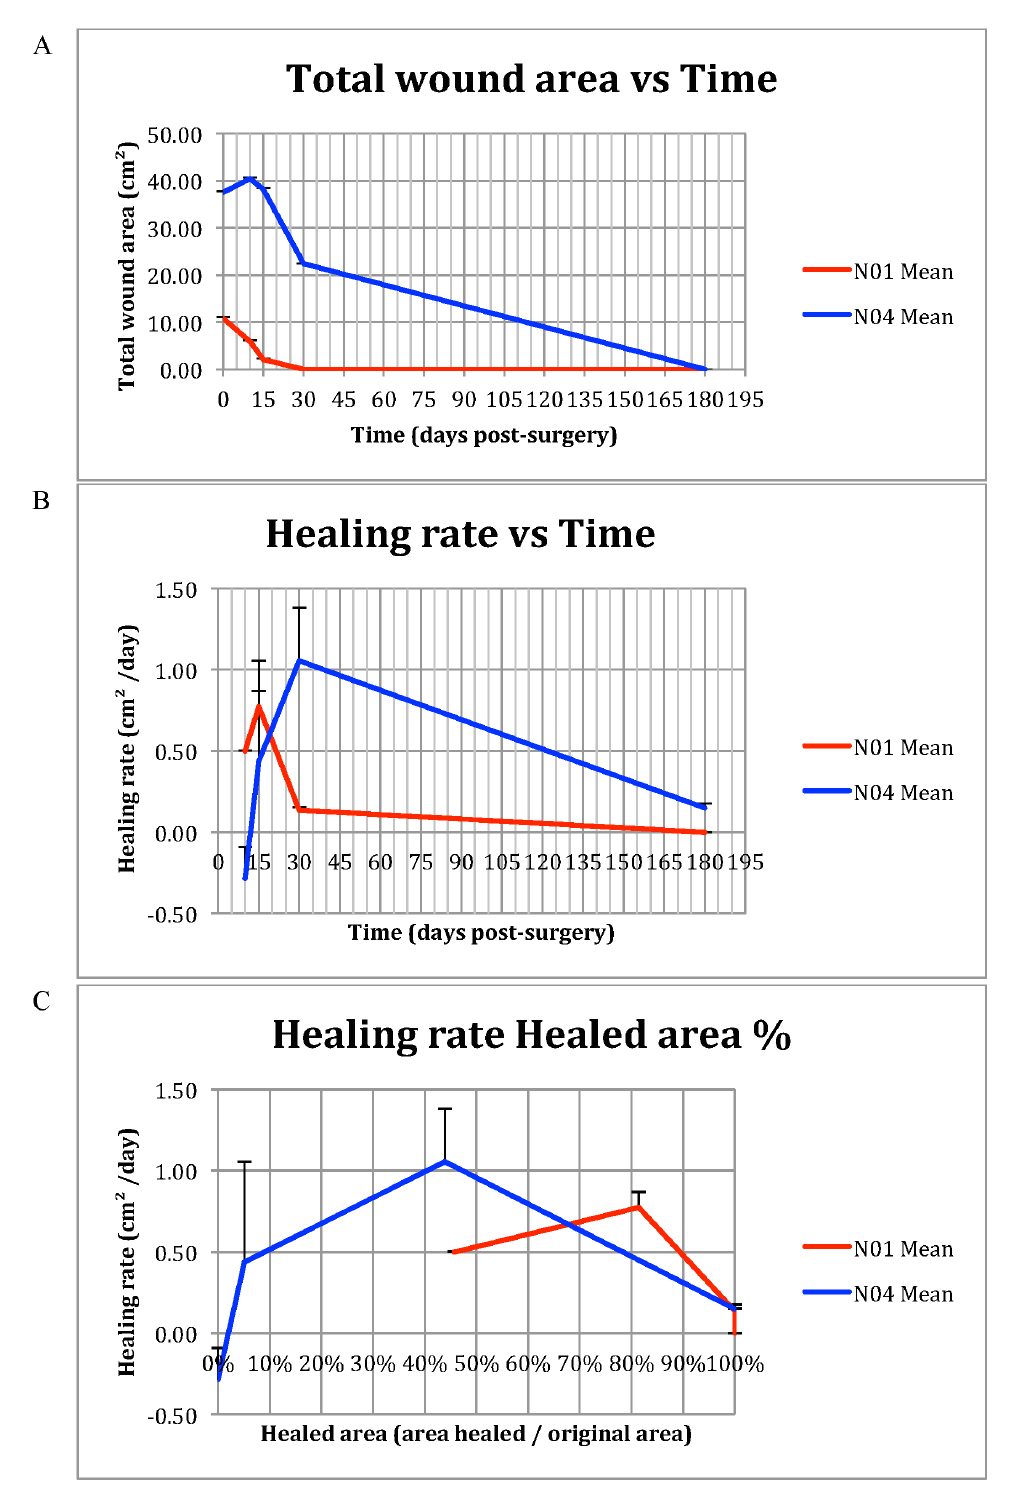
Figure 6. Graphs depicting data from Table 2. ( A ) Total wound area vs Time. ( B ) Wound healing rate vs Time. ( C ) Wound healing rate vs Wound healing percentage. Error bars indicate +1 SD from mean data